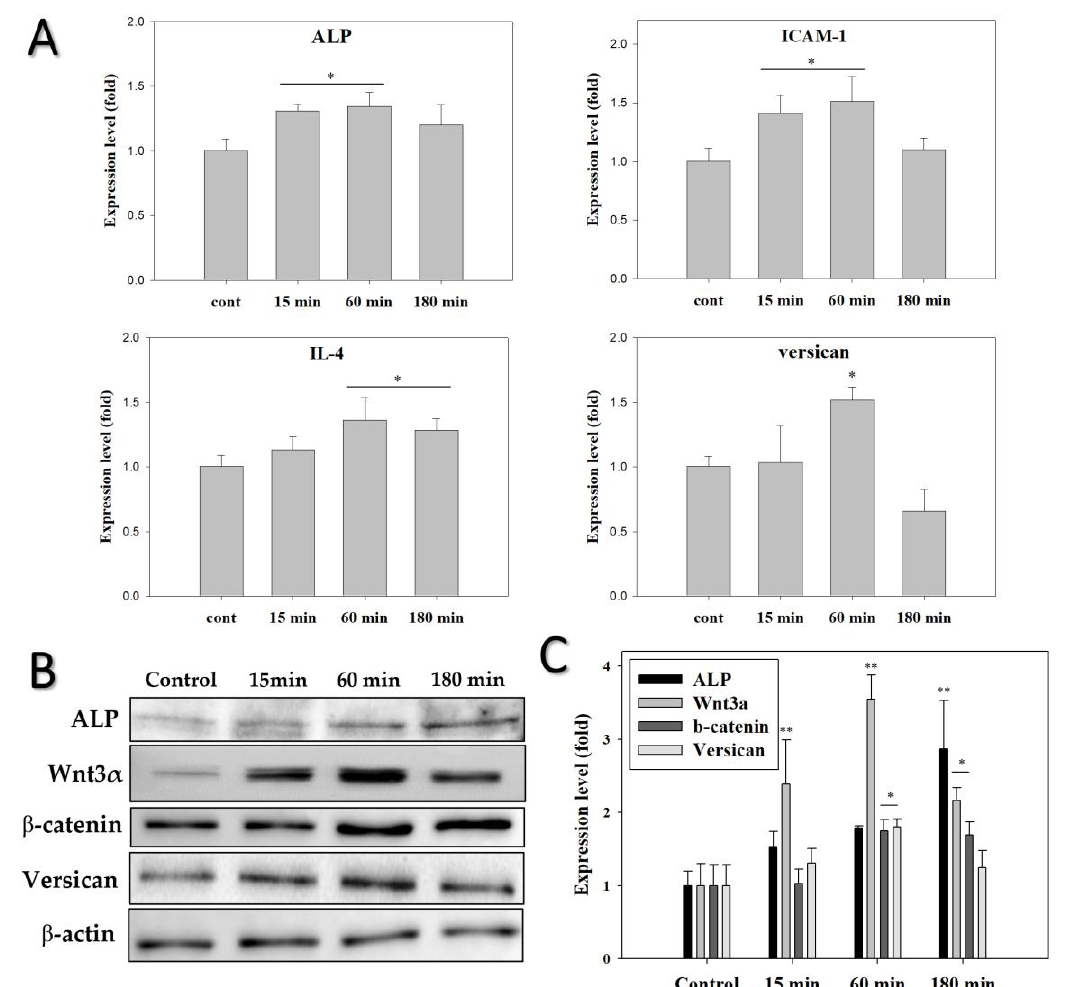
Figure 6. Gene and protein expression levels detected in human hair follicles (HFs) treated with ELF-EMF. ( A ) Gene expression of ALP, ICAM-1, IL-4, and versican measured by qPCR using β -actin as an internal control. ( B ) Protein expression of β -catenin, Wnt3 α , ALP, and versican, using β -actin as an internal control. ( C ) Protein expression of ( B ). Relative expression intensities were calculated using ImageJ. Each bar represents the mean ± standard error of independent experiments performed in triplicate ( n = 3). Significant differences were determined by one-way ANOVA with Tukey’s post hoc test (* p < 0.05, ** p < 0.01).